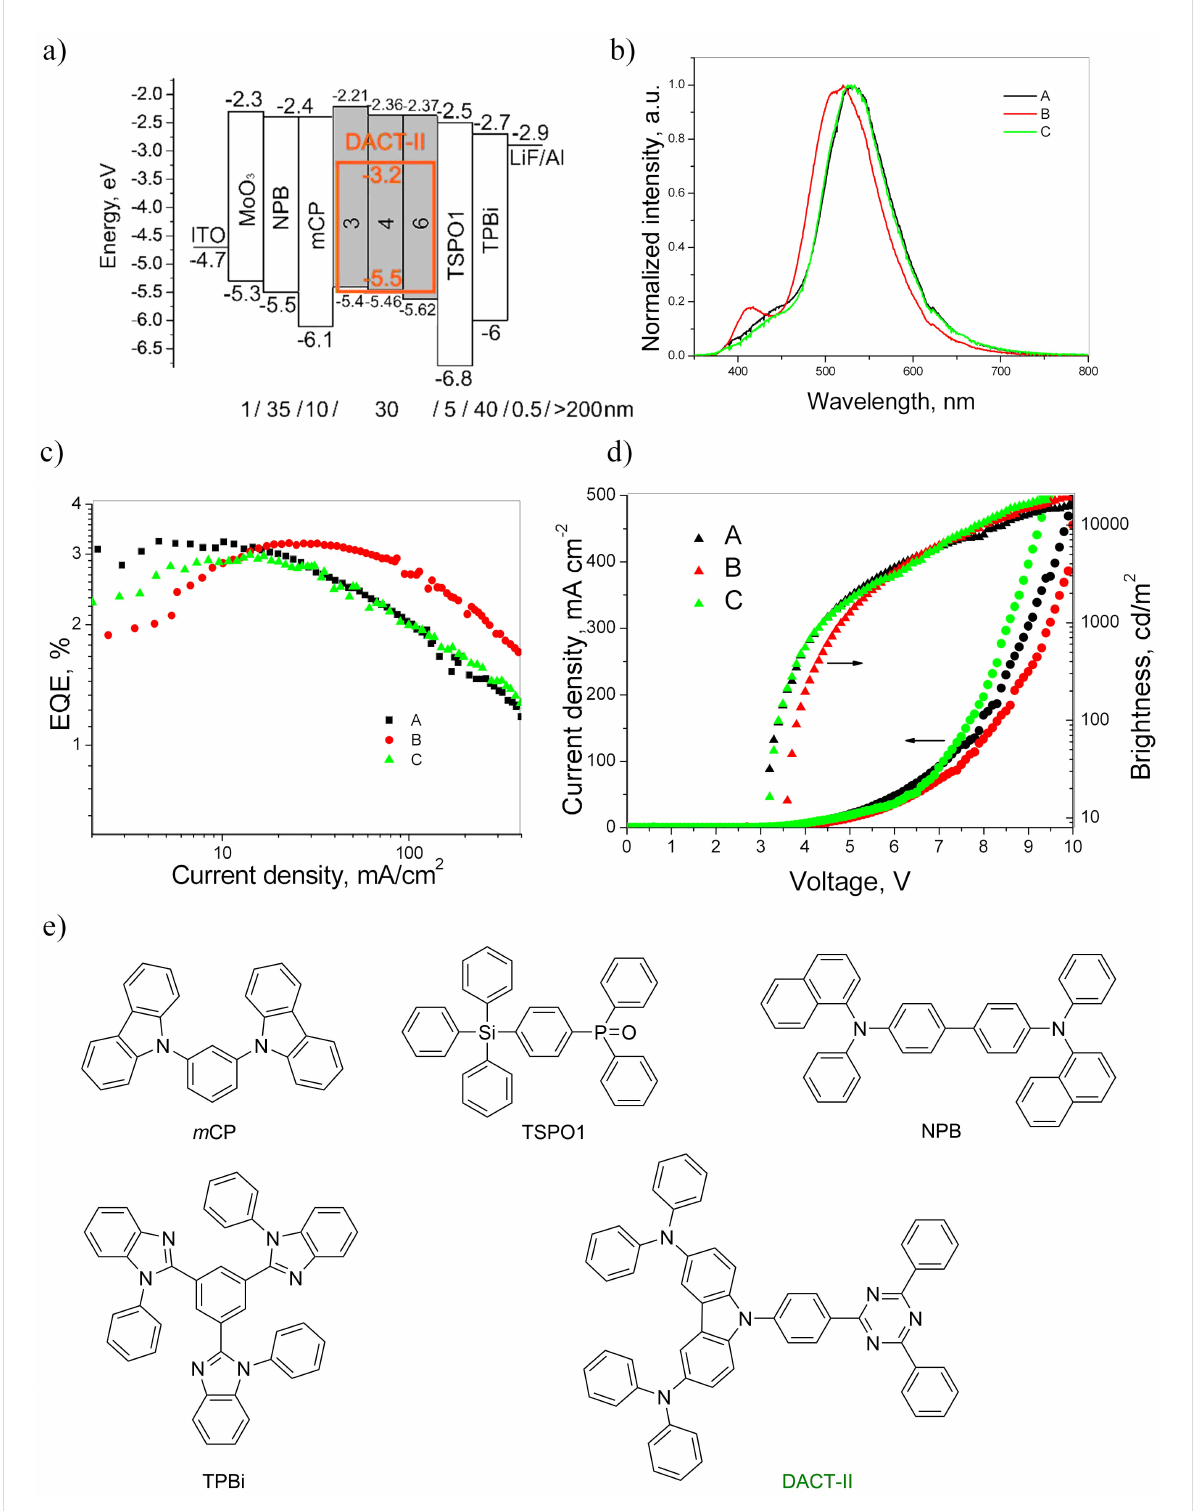
Figure 6: Energy diagrams of the fabricated OLEDs (a); normalized electroluminescence spectra of devices A–C recorded at 5 V (b); EQE versus current density plots (c), brightness and current density versus applied voltages plots (d) of the tested OLEDs; molecular structures of the organic de- rivatives used in the devices